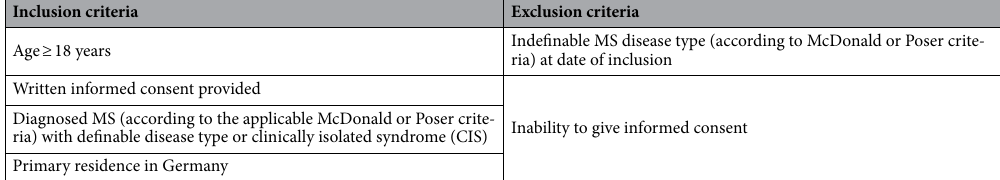
Table 1. Inclusion and exclusion criteria of the GMSR. CIS clinically isolated syndrome, MS multiple sclerosis.